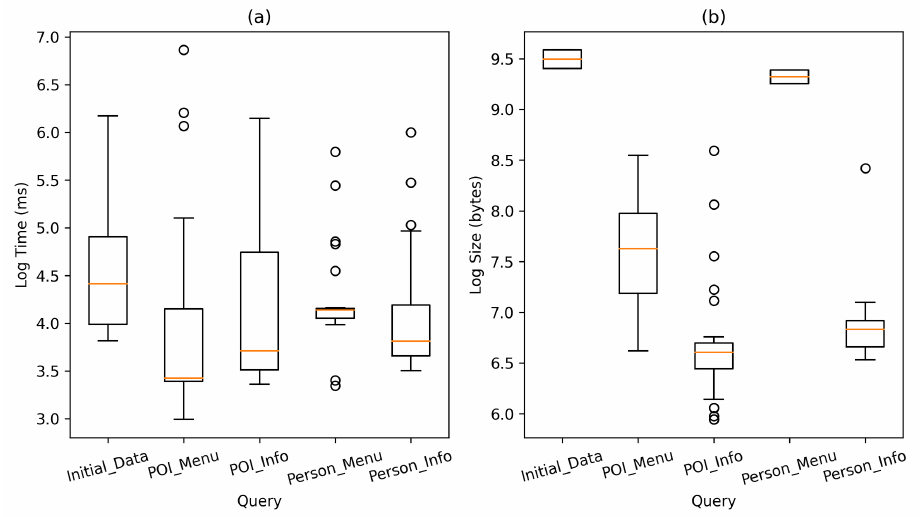
Figure 18. ( a ) Average time in milliseconds per query, ( b ) Average size in bytes per